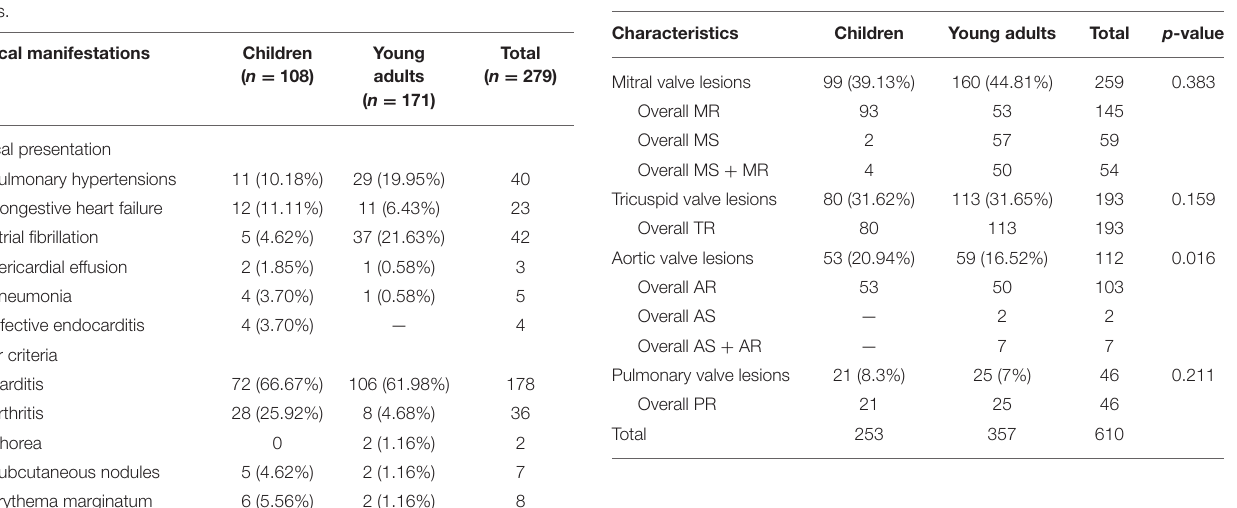
TABLE 3 | Valvular affectation in RHD